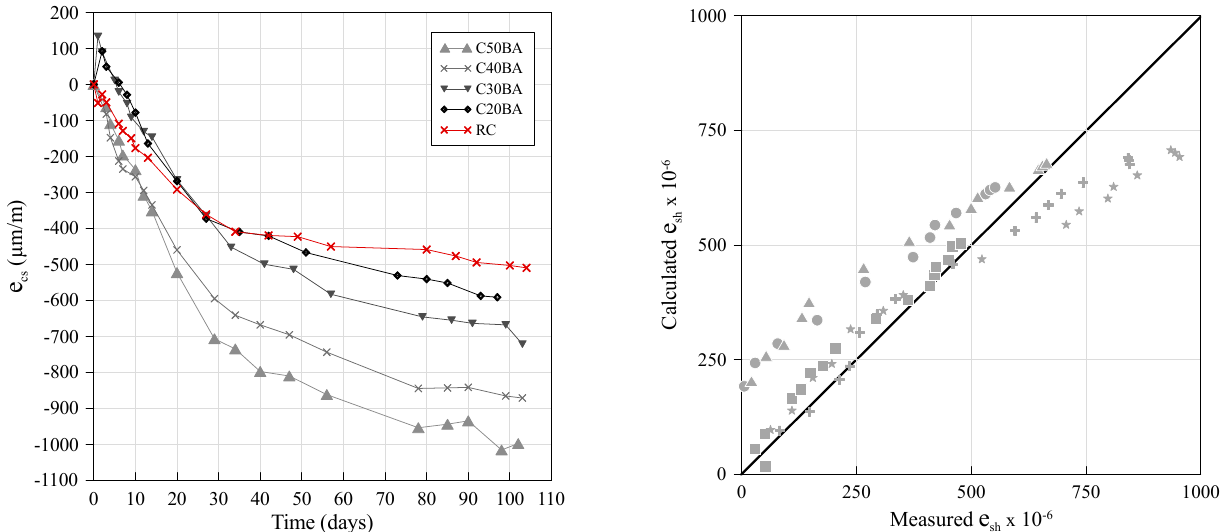
Figure 7. Total shrinkage over 91 days ( left ) and shrinkage calculated according to the Eurocode 2 [46] prediction model ( right ).